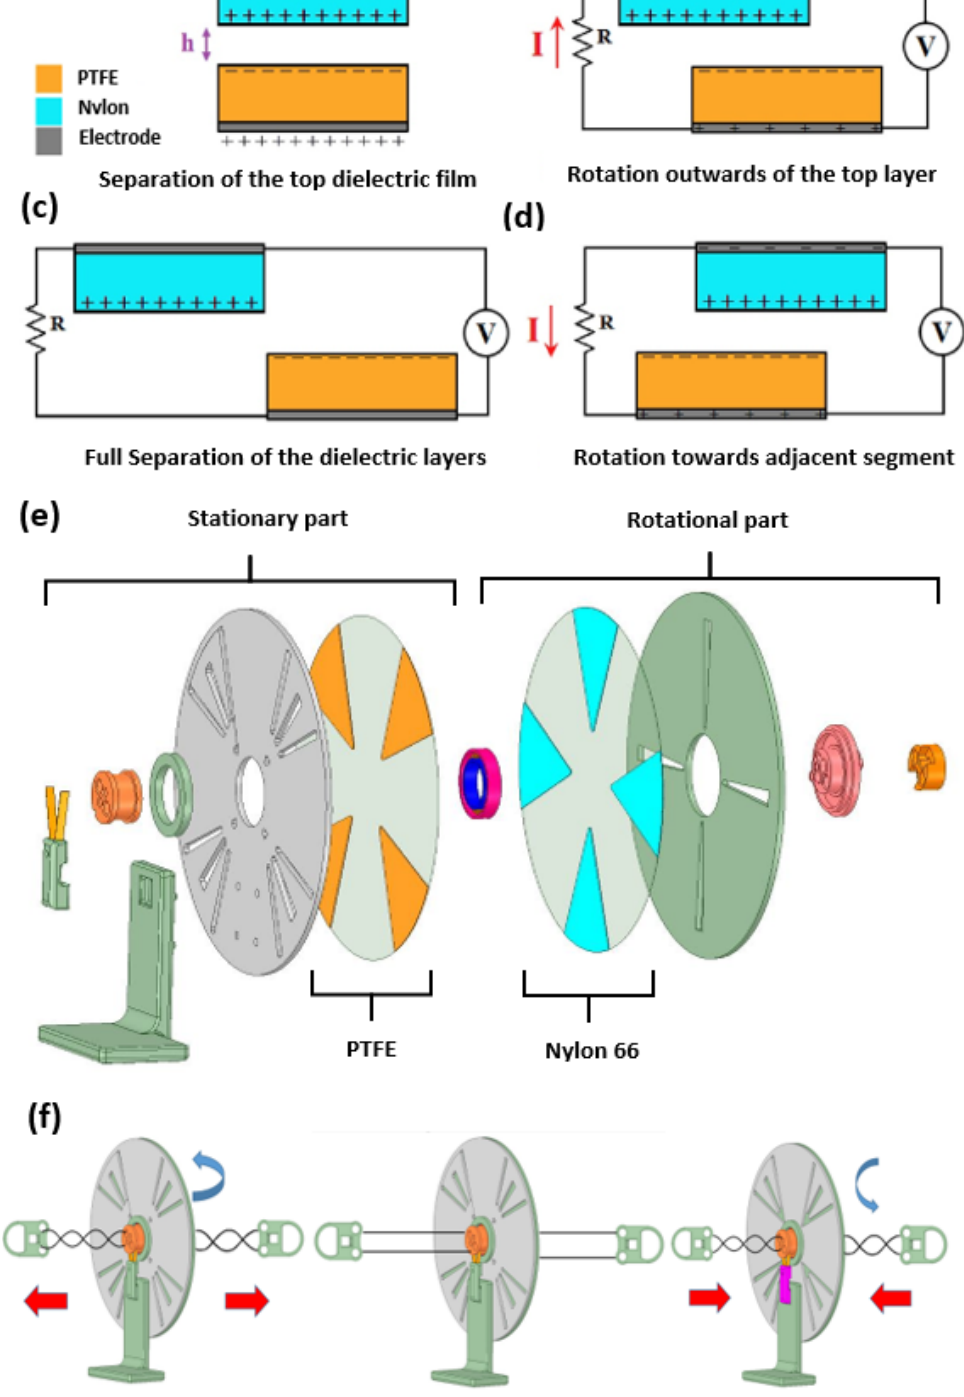
Figure 3. The working principle of the rotational TENG and the structure of the current HDR-TENG in this review; ( a ) two dielectric films are arranged so that there will be a controlled gap (h) between their surfaces; ( b – d ) the principle circuit applied on two dielectric films, When two dielectric films move relatively to each other, the change in the contact area generates the varying voltage in the circuit. Depending on the direction of the relative movements of two materials, the current in the circuit will have the corresponding direction; Reproduced with permission. [25]; ( e ) The explosion view of the HDR-TENG with all components divided into two groups of stationary part and rota- tional part. The orange and blue materials represent polytetrafluoroethylene (PTFE) and polyamide